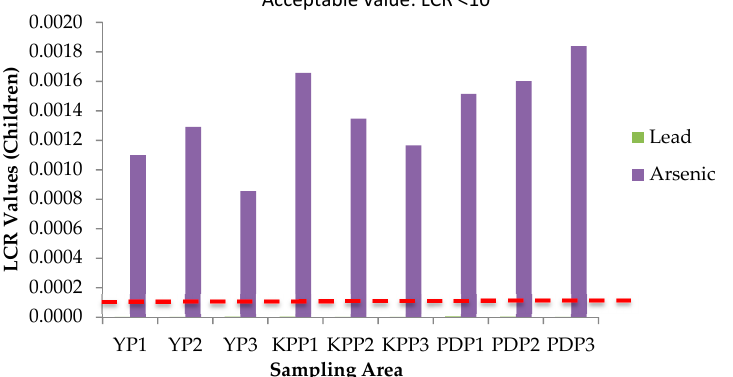
Figure 9. Lifetime cancer risk (LCR) values of adults and children for three plots of Yan, Kubang Pasu, and Pendang. YP1: Yan Plot 1, YP2: Yan Plot 2, YP3: Yan Plot 3, KPP1: Kubang Pasu Plot 1, KPP2: Kubang Pasu Plot 2, KPP3: Kubang Pasu Plot 3, PDP1: Pendang Plot 1, PDP2: Pendang Plot 2, and PDP3: Pendang Plot 3.